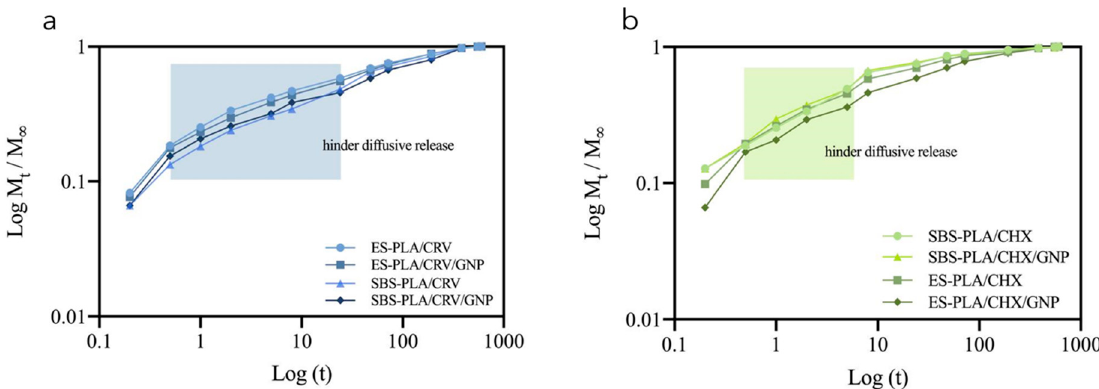
Figure 11. Logarithmic plots of power law model applied to the release data collected in the region M t /M ∞ < 0.6 for all CRV (a) and CHX (b) containing systems. Table 2. Values of slopes ( 𝑛 ) and intercepts ( 𝑘 ) of fitting of Peppas–Korsmeyer model power law applied to the release data collected in the burst region (M t /M ∞ < 0.6).